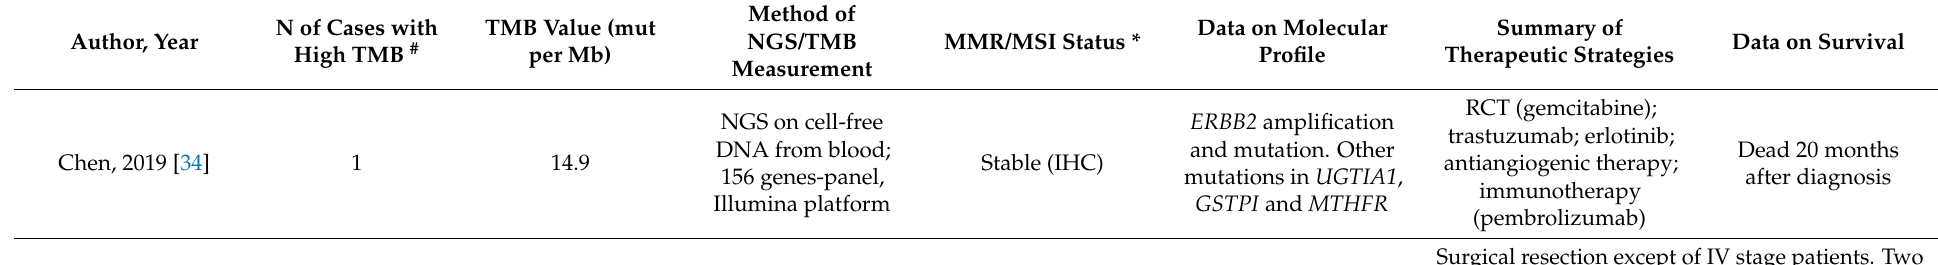
Table 2. Summarizing table of the main molecular features and survival data of all PDAC tested for tumor mutational